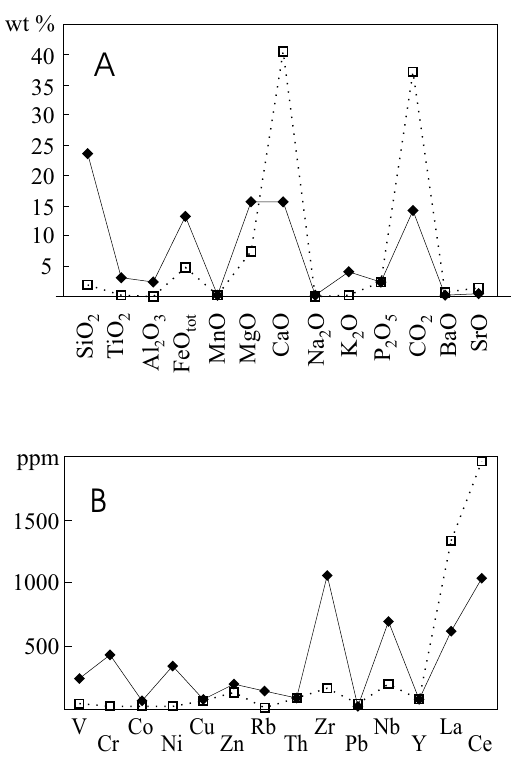
Fig. 10 –Average major (A) and trace element (B) compositions of carbonatites (CaC+MgC+FeC, square) and mica-rich rocks (G+MOP+MC, diamond) from